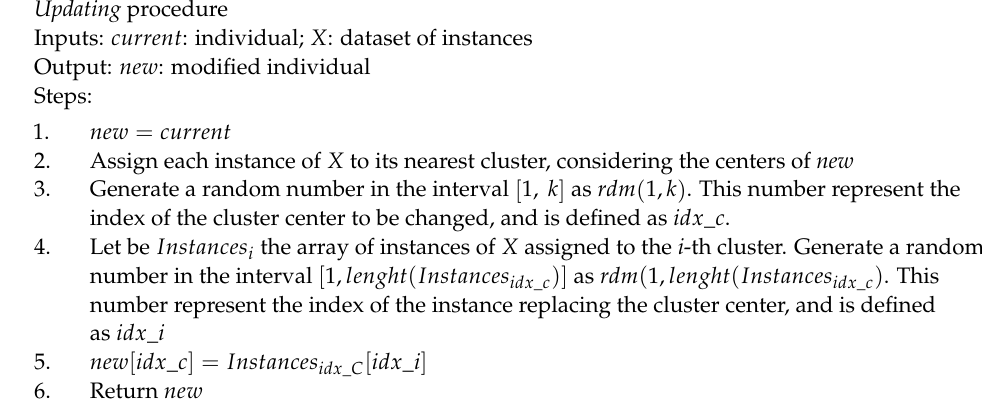
Algorithm 1. Pseudo code of the Updating procedure in the proposed framework to clustering mixed